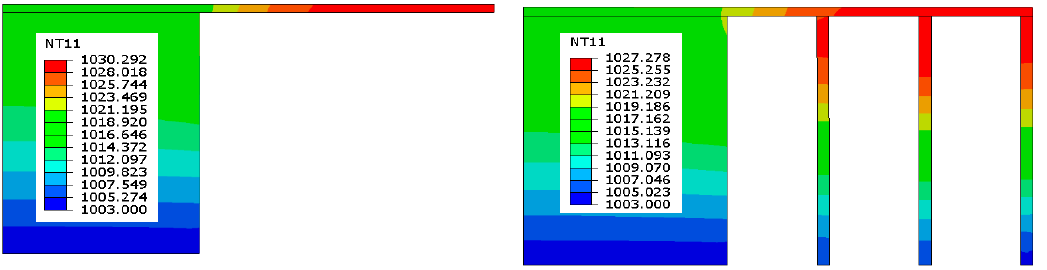
Figure 12. Temperature distributions (K) after the end of cooling steps for the 10th layer.